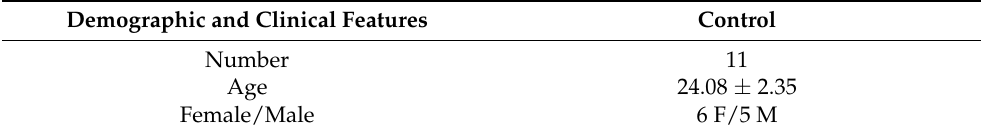
Table 1. Sociodemographic data of the control subjects (Age in years, mean ± standard deviation, SD). Demographic and Clinical